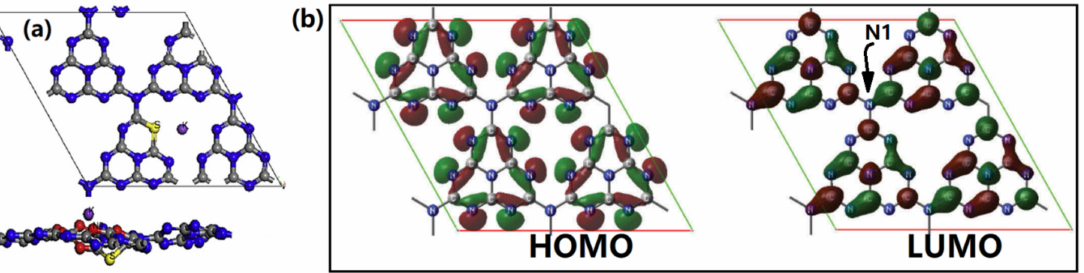
Figure 9. ( a ) The top and side views of bending K, S-GCN, and ( b ) the frontier molecular orbital of the pure GCN layer. Reproduce with permission from Ref.